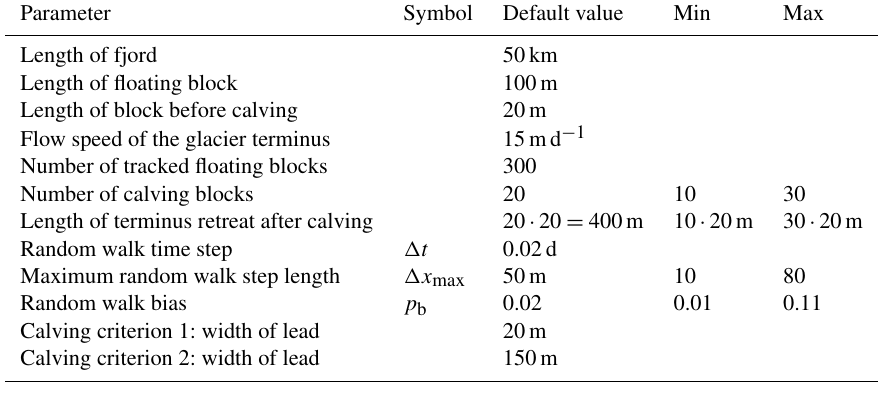
Table 1. BRIMM parameters and their ranges explored in this study.